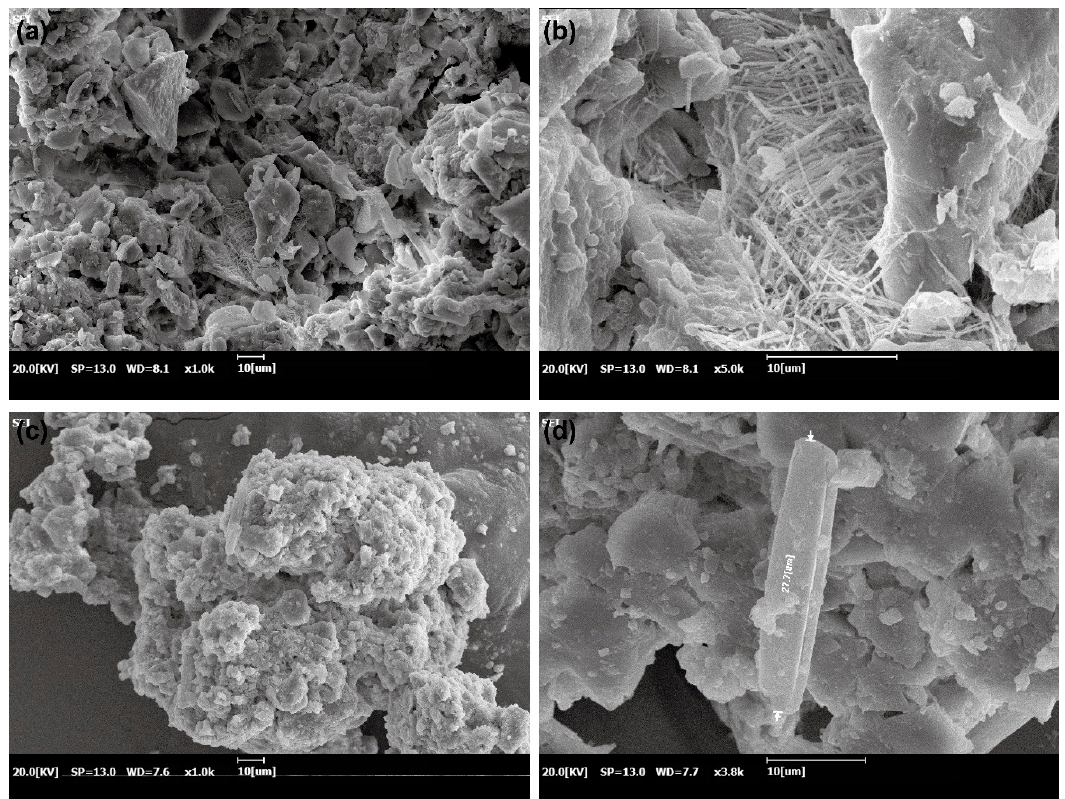
Figure 9. Scanning electron microscopy (SEM) analysis showing the matter precipitated by water sample evaporation ( a , b ) Hamaengbang area; ( c , d ) Gyogok area.